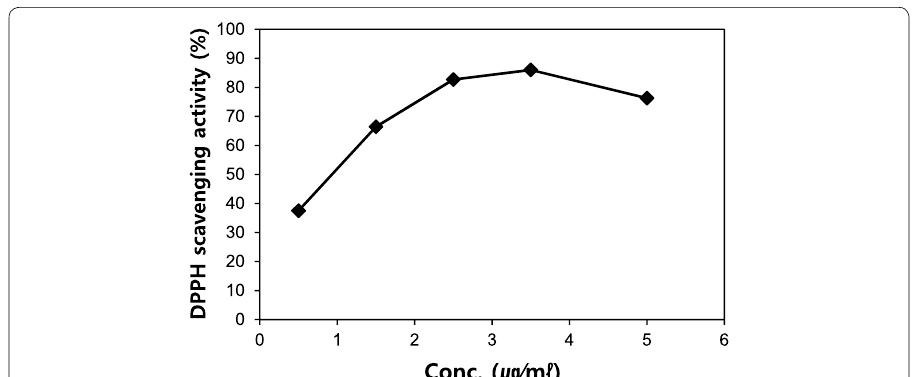
Fig. 1 DPPH radical scavenging activity of the persimmon extract